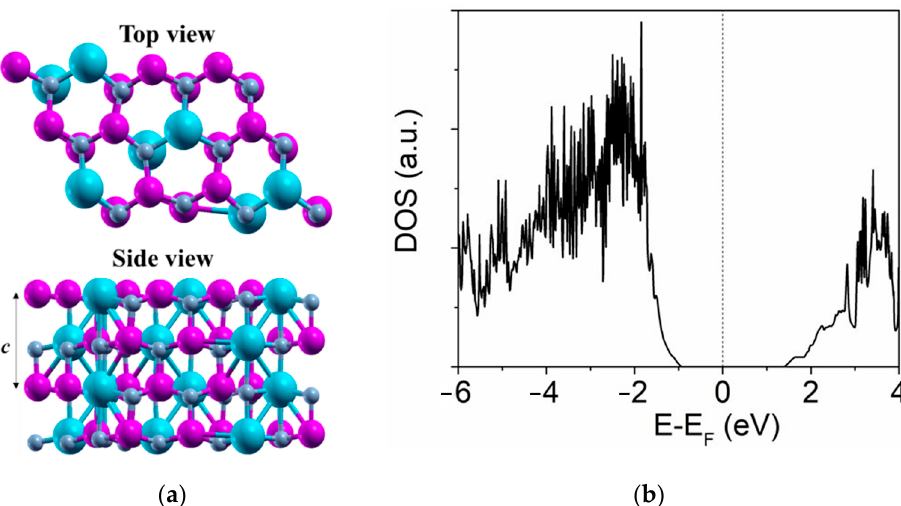
Figure 3. ( a ) Top and side views of the calculated crystal structure; and ( b ) density of states (DOS) for the Sc 0.29 Al 0.71 N crystal. The purple, grey, and bluish spheres denote Al, N, and Sc atoms, respec- tively.